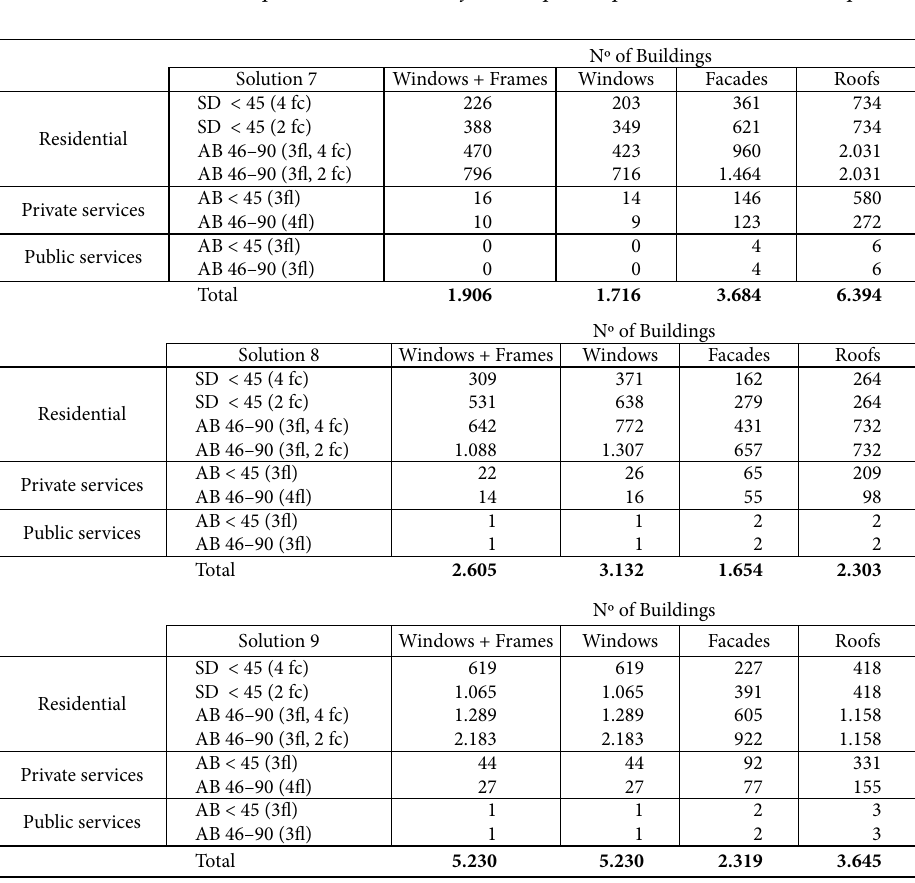
Fig. 6. Number of buildings subject to refurbishment interventions for the solutions obtained with a pessimistic